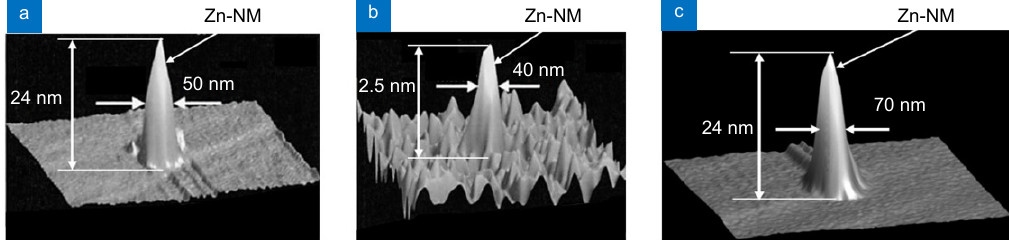
Fig. 1 | Shear-force microscopic images of Zn-NMs formed on a sapphire substrate. Dissociated molecules are DEZn (( a ) and ( b )) and Zn(acac) 2 ( c ). The wavelengths of the propagating light for creating the DP were 488 nm (a), 684 nm (b), and 457 nm (c).